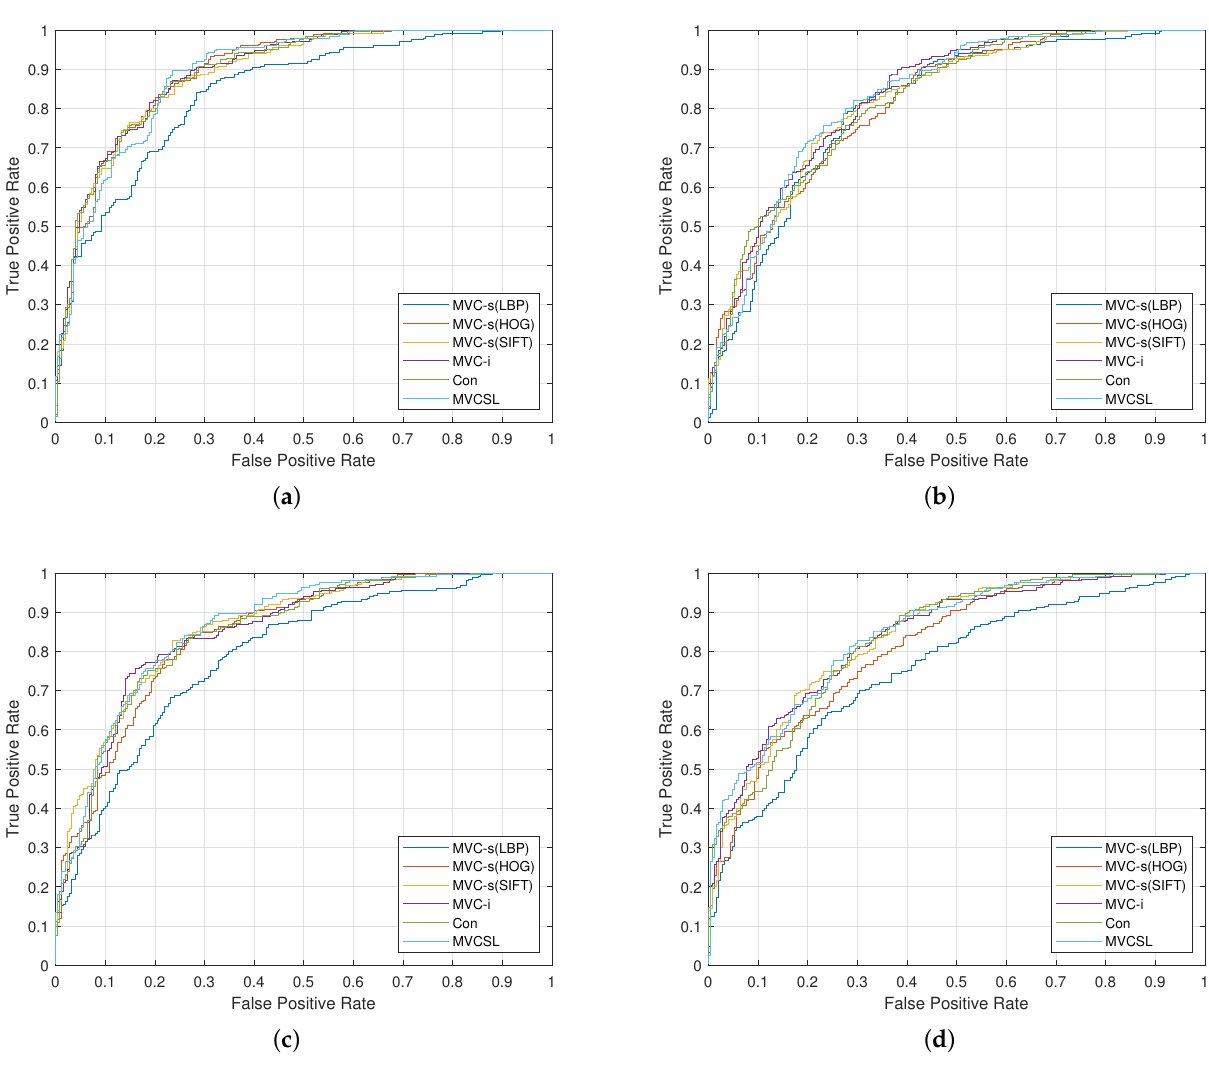
Figure 6. ROC curves of the proposed MVCSL and baseline methods on the KinFaceW-II dataset. ( a ) F-S, ( b ) F-D, ( c ) M-S, ( d )